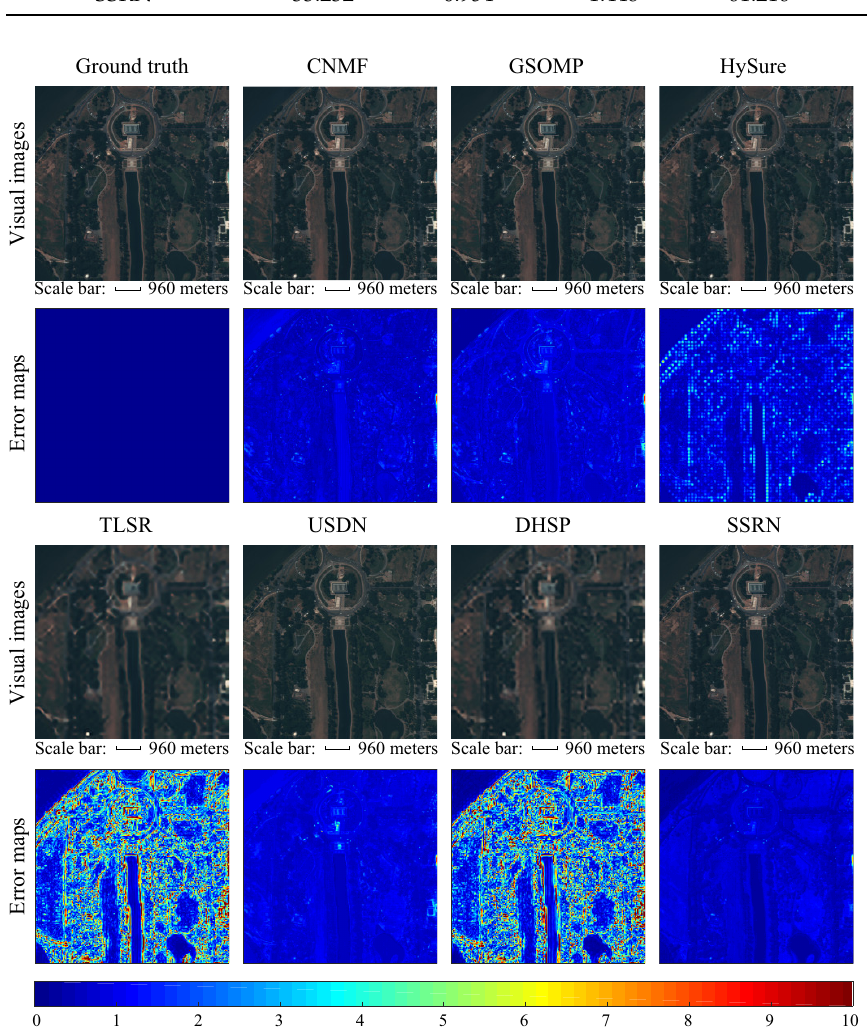
Figure 5. Visual images (R: 50, G: 30, and B: 20) and error maps of SSRN and the compared methods on the WDCM